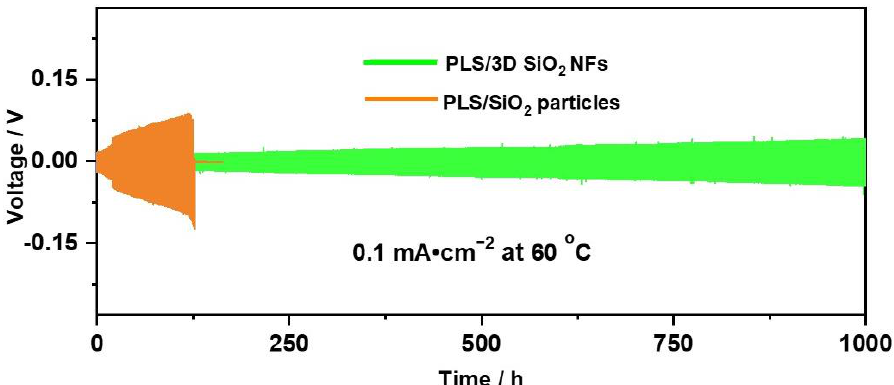
Figure 4. The voltage profiles of Li symmetrical cells with PLS/SiO 2 particles and PLS/3D SiO 2 NFs at a current density of 0.1 mA cm −2 with 0.5 h stripping/0.5 h plating alternating